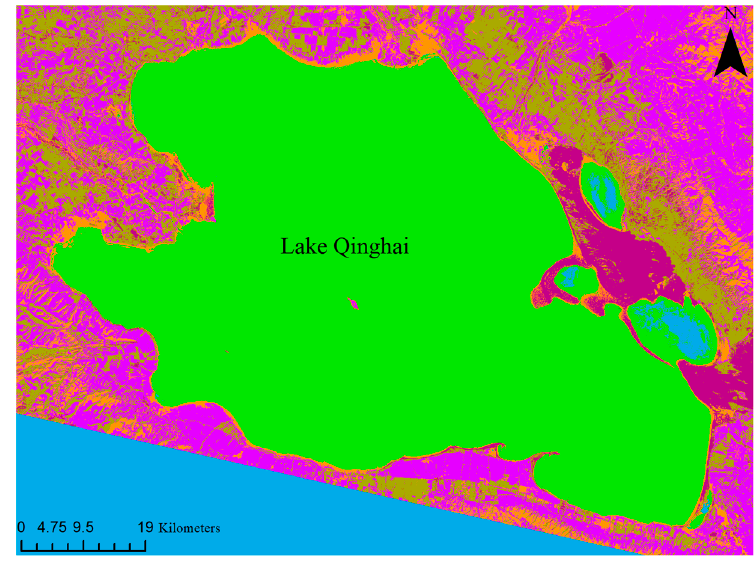
Figure 9. Image after unsupervised classi fi cation